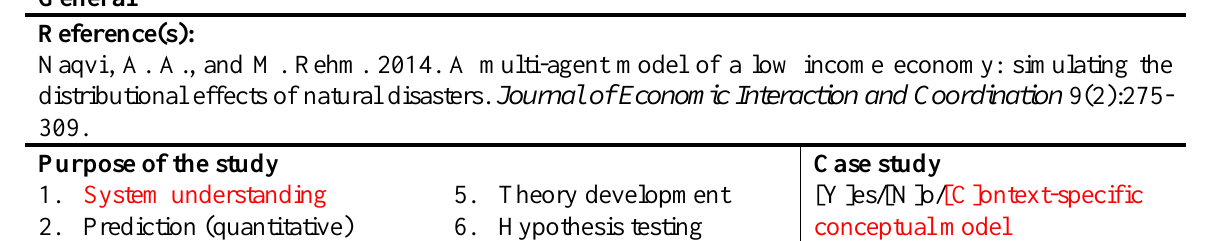
Table A1.9 Standardized protocol for the ABM described by Naqvi & Rehm